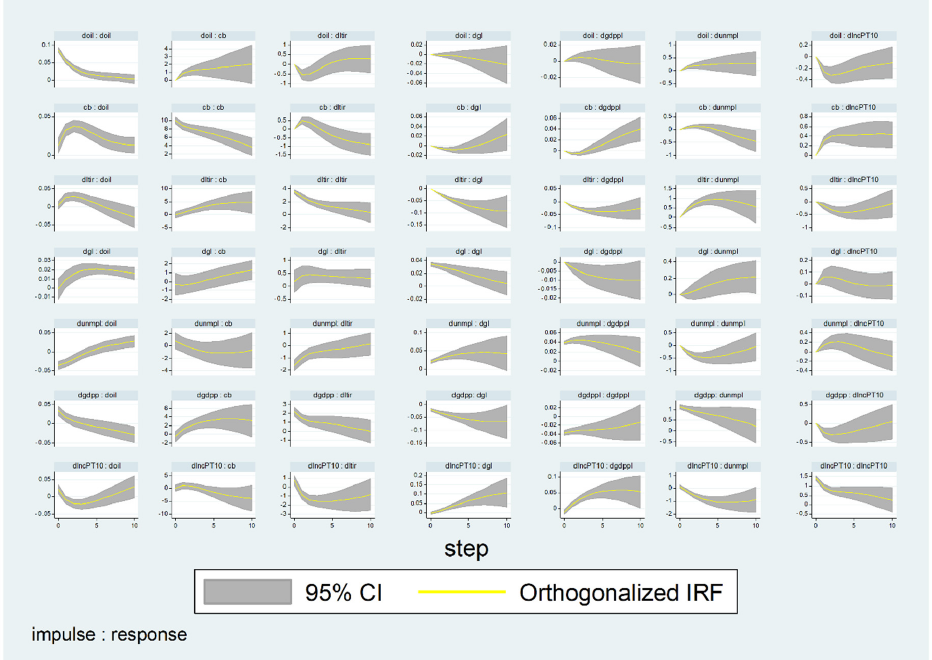
Figure A1. Eigenvalue stability condition when PTI10% is used to measure income inequality. Note: All the eigenvalues lie inside the unit circle. PVAR satisfies stability condition. Source : Author’s illustration based on SWIID (Solt 2020; World Development Indicators 2022).